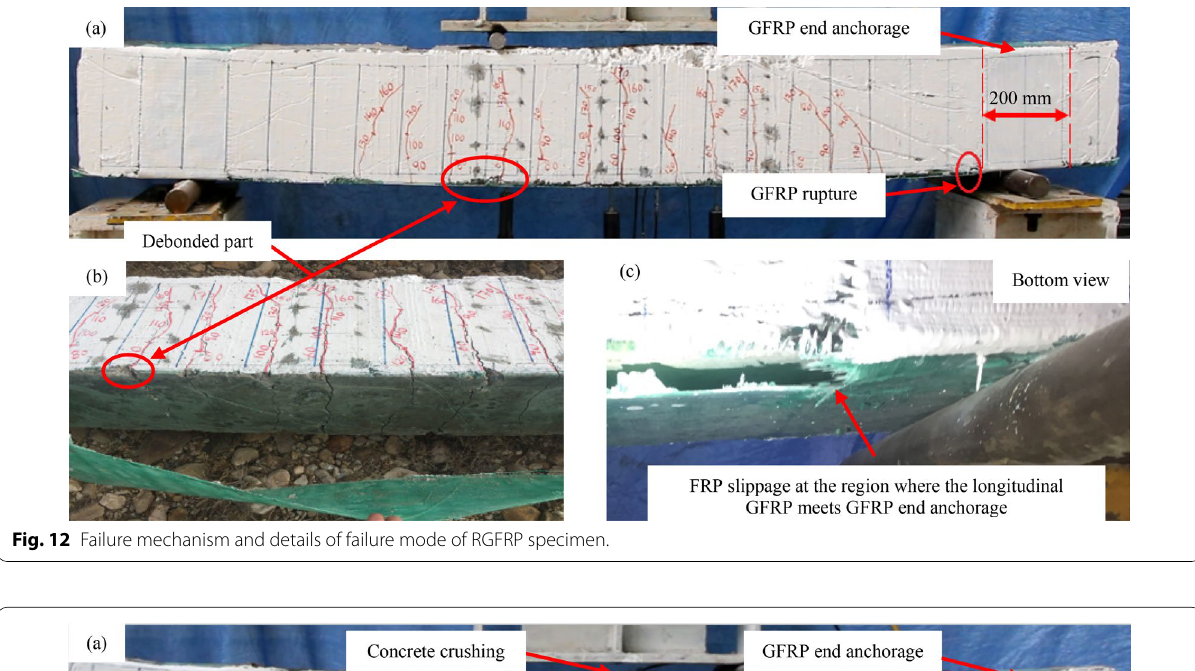
Fig. 12 Failure mechanism and details of failure mode of RGFRP specimen.